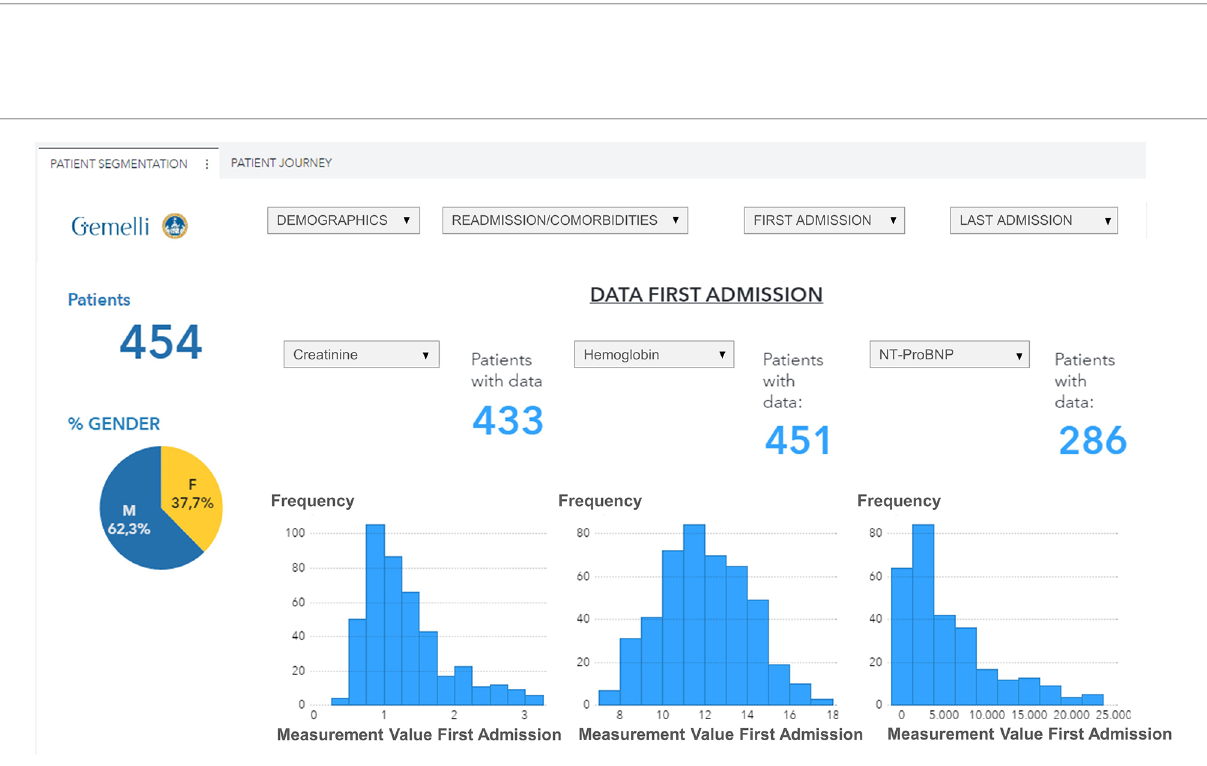
FIGURE 5 Comparison of eGFR values between fi rst and last hospitalization event for a patient subgroup (patients with age <90 years, diabetes and hypertension, period 2019 –